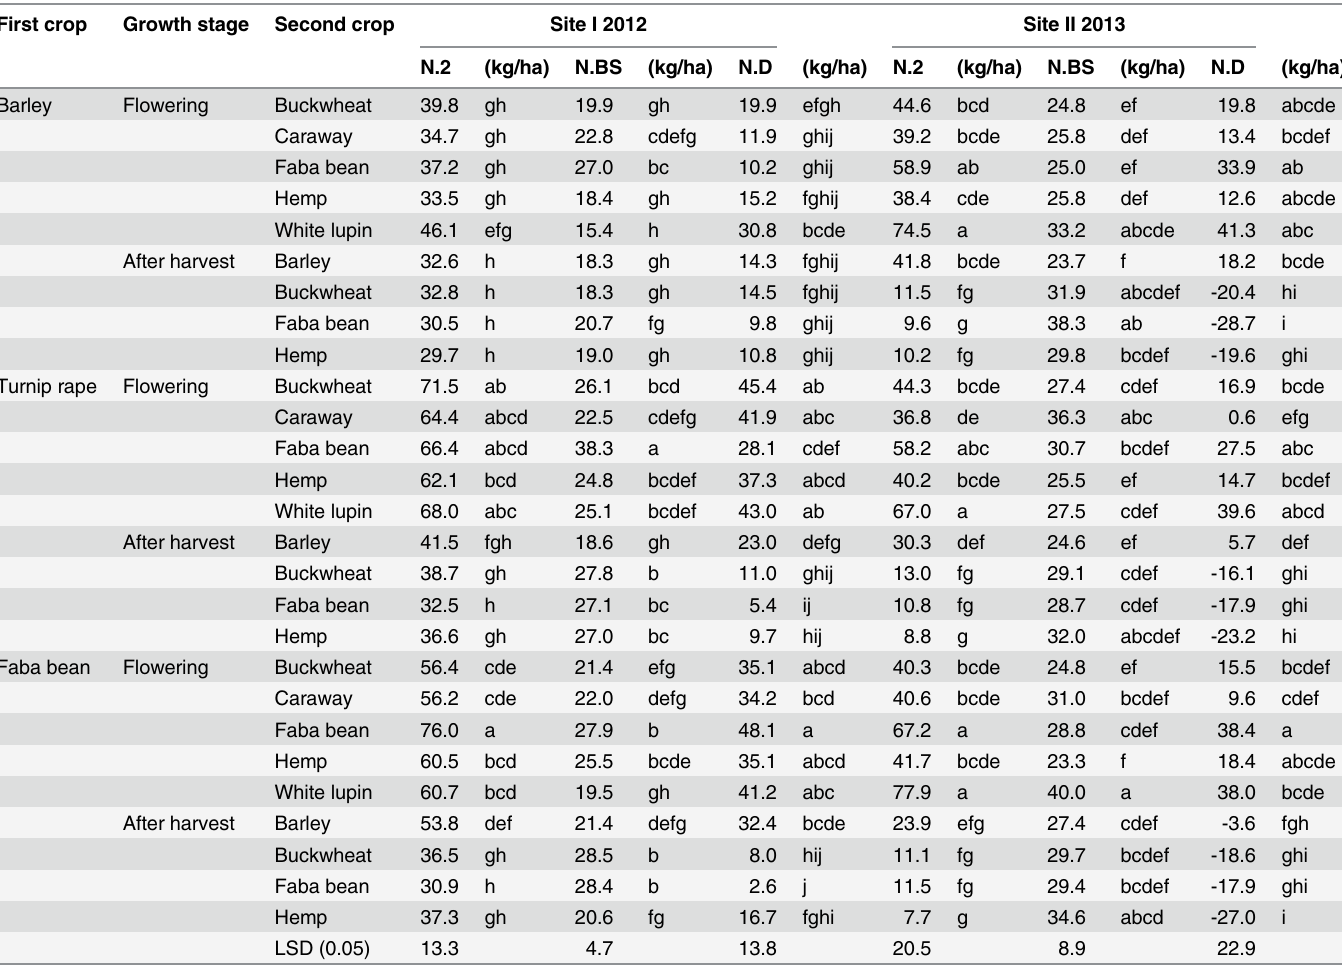
Table 5. Soil nitrogen content two months after incorporation of crop residues (N.2), soil nitrogen content before sowing barley (N.BS), and differ- ence between N.2 and N.BS (N.D). First